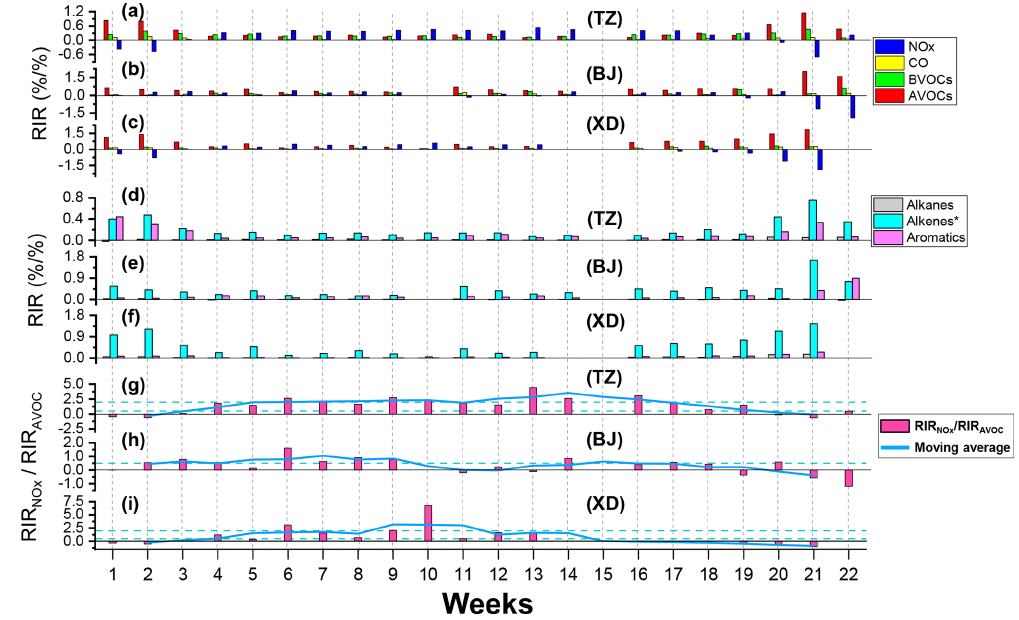
/ RIR AVOC at three sites (TZ, BJ, and XD) in x / RIR AVOC values. x